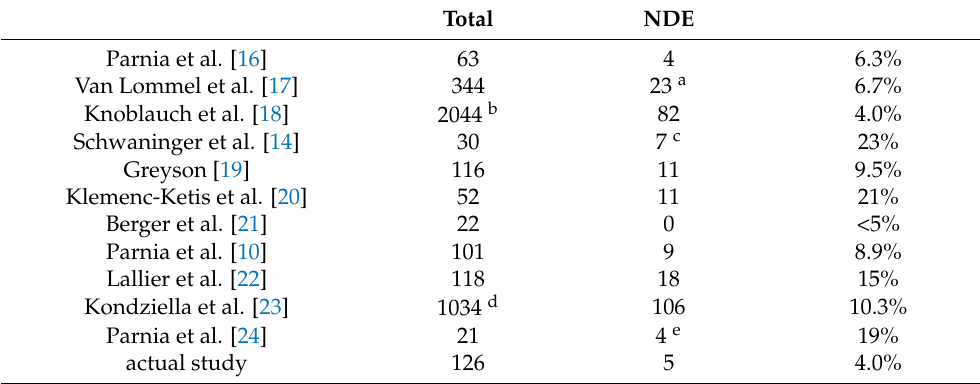
Table 2. NDE studies in comparison. Number of subjects reporting an NDE in comparison to the total number.